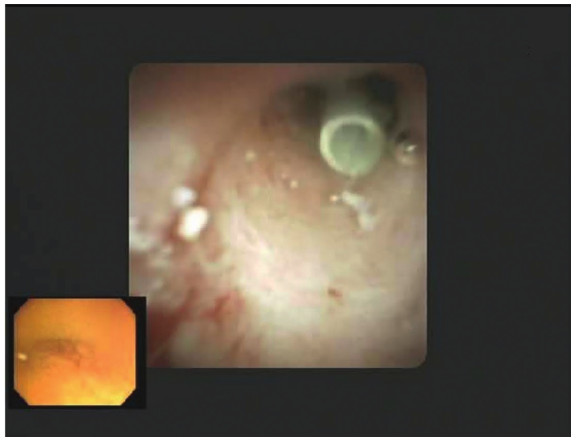
Figure 3: Showing migrated Pancreatic duct stent.